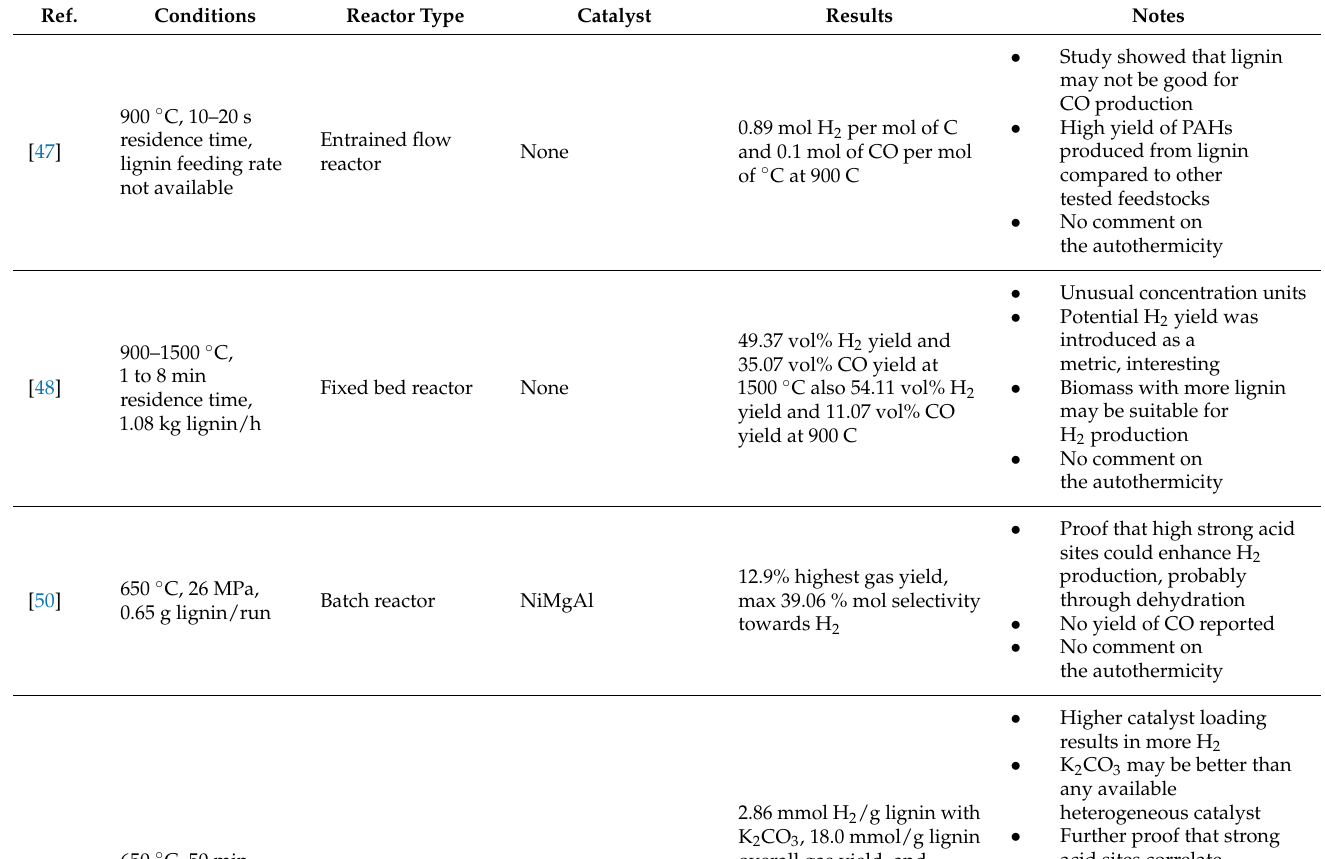
Table 4. Comparative table of the studies about lignin gasification in water or steam